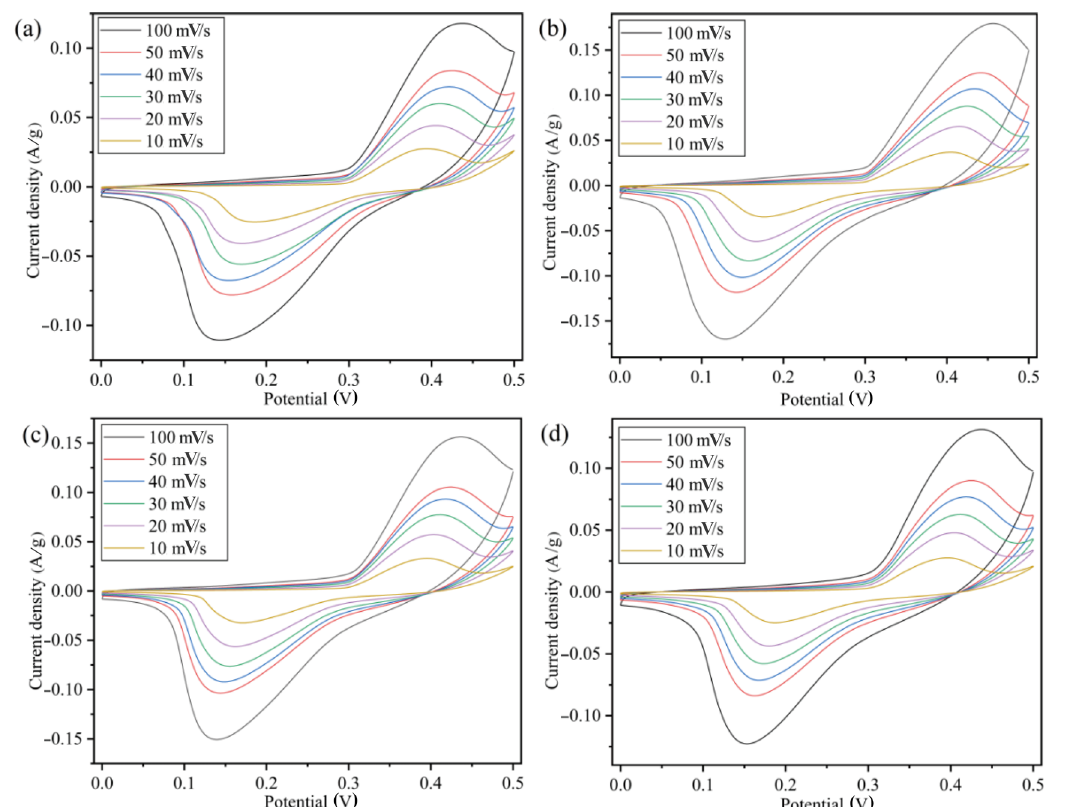
Fig. 6 CV curves of La(CoCrFeMnNiAl x ) 1/(5+ x ) O 3 − δ : (a) x = 0.4, (b) x = 0.5, (c) x = 0.6, and (d) x = 0.7. Table 3 Specific capacitances